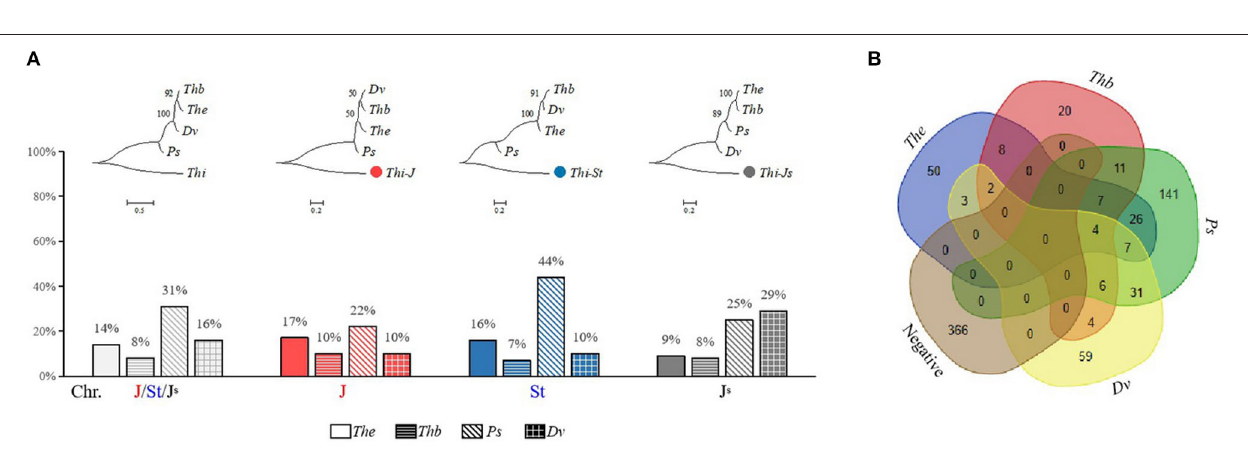
FIGURE 5 | Identification of wheat- Th. intermedium translocation line T1332. The probes were Oligo-k288 (red) + Oligo-B11 (green) (A) and Oligo-pSc119.2 (green) + Oligo-pTa535 (red) (B) . Bars, 10 µ m. The chromosomes in the karyotype (C) were 4B, 4J, and T4BS/4JL, respectively, and the arrows pointed to the translocation breakpoints. (D) Amplification of 4J-, 4St-, and 4J s -specific markers in Th. intermedium and six wheat- Thi introgression lines. (E) The position of 21 Thi -specific markers on 4J physical and linkage maps. Red markers are 4J-specific, four of which with amplification products in translocation line T1332 are marked with plus sign.